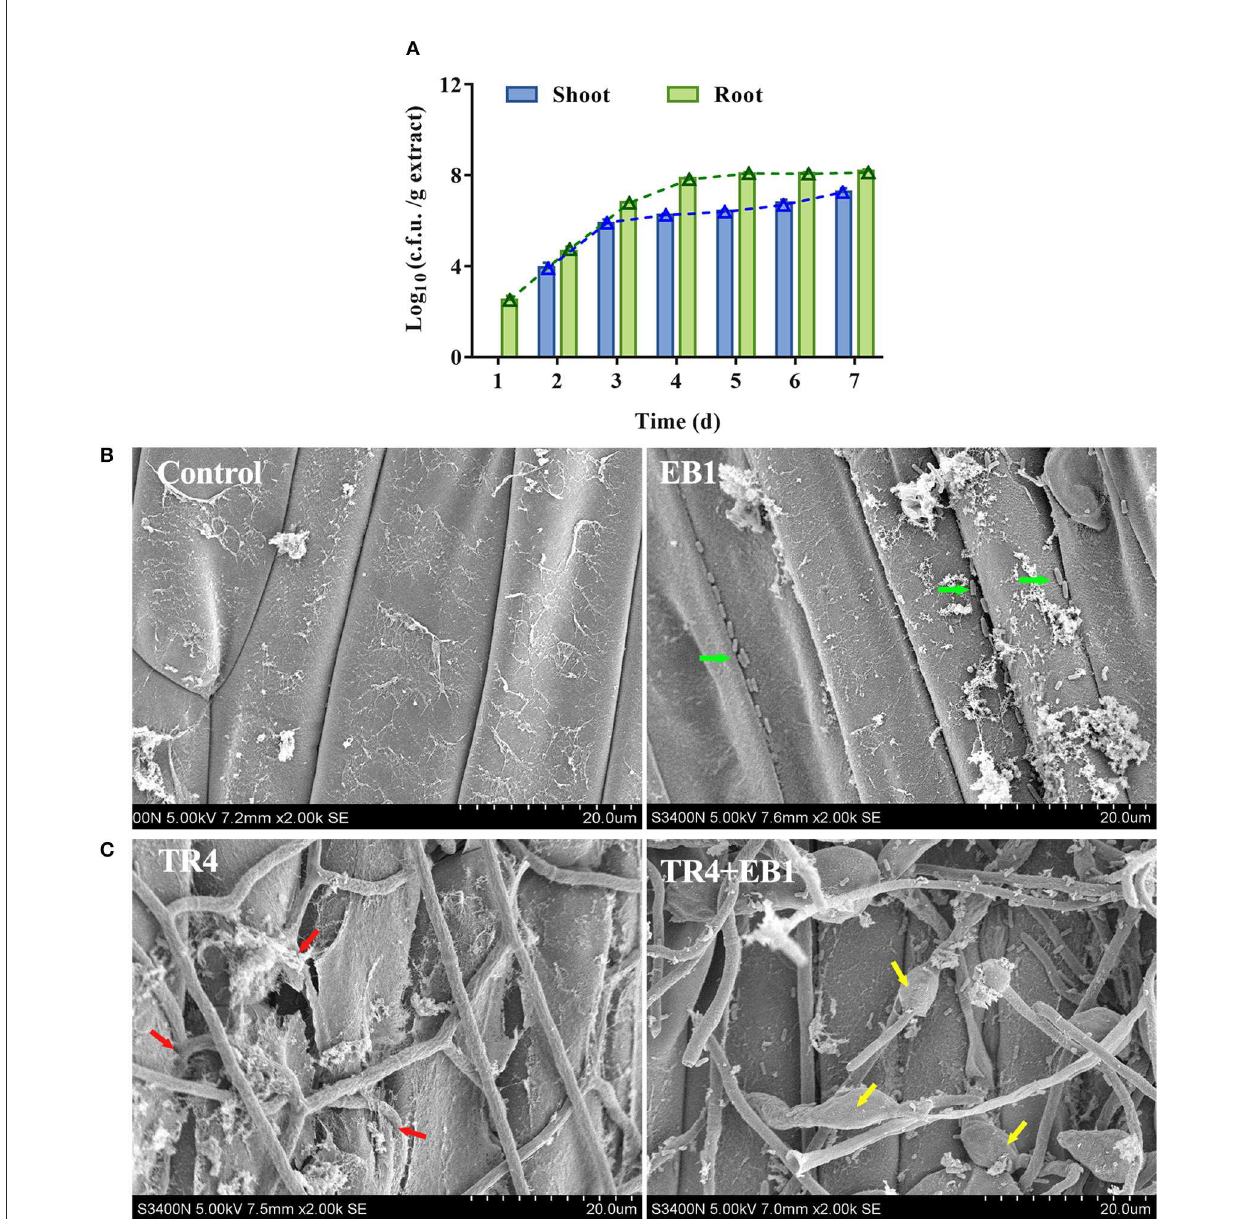
FIGURE3 Strain EB1 showed strong colonization ability on the banana plantlets and provided protection against the infection of TR4. (A) EB1 dynamics (c.f.u. counts) in shoot and root extracts during the first 7 days after banana tissue culture plantlets bacterized. Bars represent average values ± SD of total c.f.u. in shoot and root extracts. Green and blue lines represent c.f.u. corresponding to the number of spores in shoot and root extracts, respectively. (B) Root colonization of strain EB1 visualized by scanning electron microscopy (SEM). Strain EB1 colonies occur in grooves between epidermal cells and intercellular space in root cells (marked by green arrow heads). (C) Strain EB1 inhibits the infection of TR4 in planta . TR4 seriously destroyed the surface structures of the root of banana tissue culture plantlets (marked by red arrow heads) and inoculation of EB1 prior to Foc treatment led to serious morphological deformities of Foc and the damaging effects by pathogen infection were alleviated (marked by yellow arrow